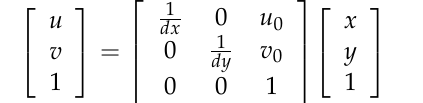
Figure 4. Results of visual persistent positioning.